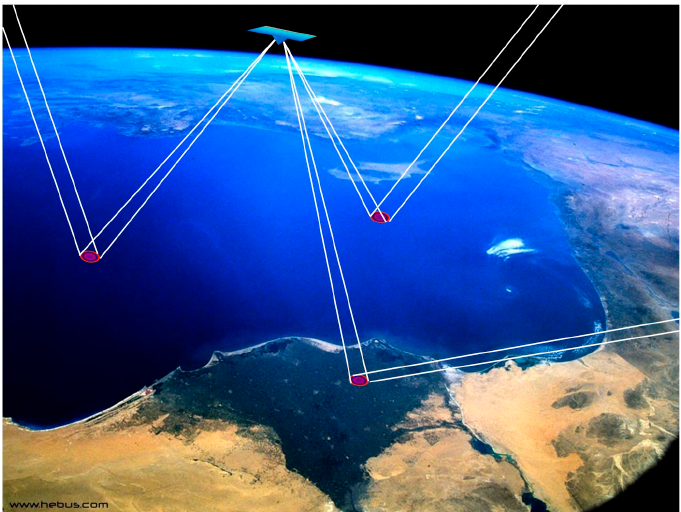
Figure 1. General illustration of three GNSS-R reflection specular points captures by a single LEO receiver. Reprinted with permission from ref. [16], Copyright: 2014, IEEE. receiver. Reprinted with permission from ref. [16], Copyright: 2014,